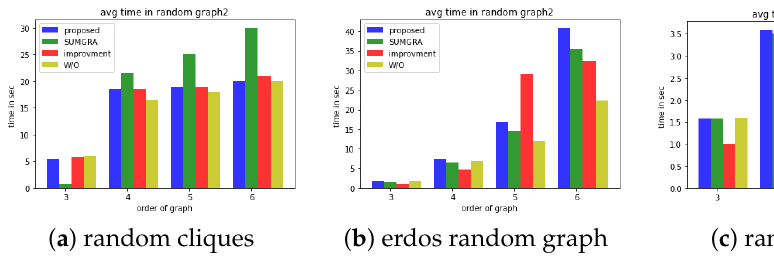
Figure 13. Query time on random graph1 dataset.